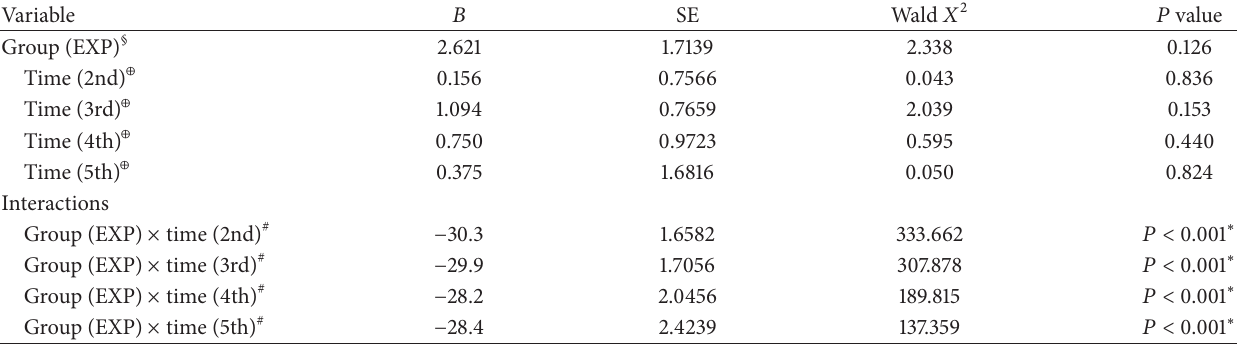
Table 3: GEE analysis of BDI-II results.